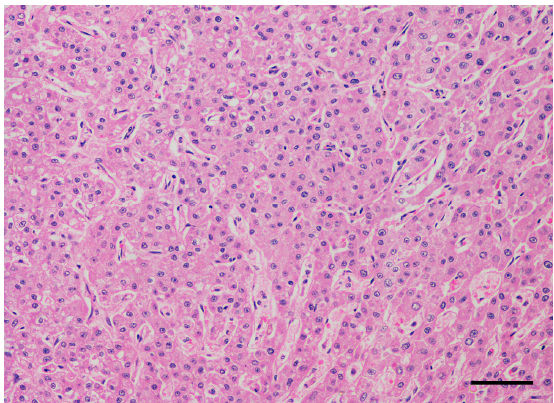
Figure 1. Dog, liver. Histological sample of hepatocellular carcinoma. The tumor is well-differentiated and composed by variably thick trabeculae formed by neoplastic hepatocytes (trabecular pattern). Hematoxylin and eosin. Bar, 100 µm.